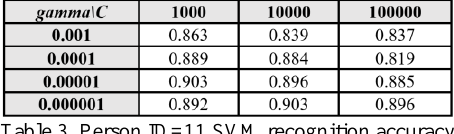
Table 3. Person ID=11 SVM recognition accuracy